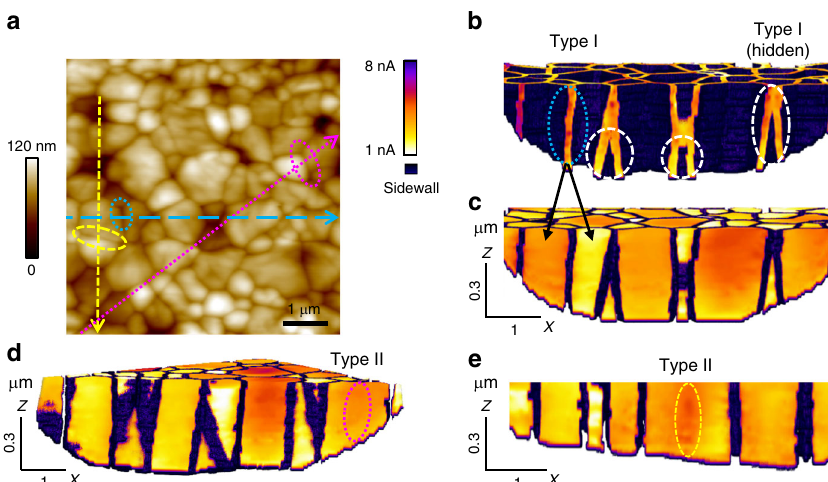
Fig. 4 3D identi fi cation of two GB types for polycrystalline MAPbI 3 . a 6 µ m × 6 µ m AFM topography of as-grown MAPbI 3 thin- fi lm surface before T- AFM. b – c Segmented cross-sectional tomograms of GBs and grains respectively, revealing Type I GBs at and hidden beneath the surface along the blue long-dashed line from ( a ). d – e Cross-sectional tomogram of Type I as well as insipid Type II GBs, along pro fi les respectively indicated by magenta dotted line and yellow dashed line in ( a ). Speci fi c interfaces highlighted by overlain ovals in ( a ) are equivalently identi fi ed in ( b , d , e ), demonstrating absolute through-thickness differences in photocurrents for Type I and II GBs despite being topographically indistinguishable at the surface.